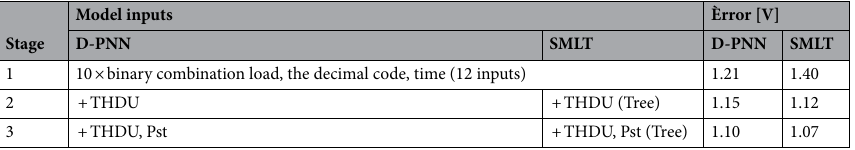
Table 1. Voltage U 3-step model estimations.